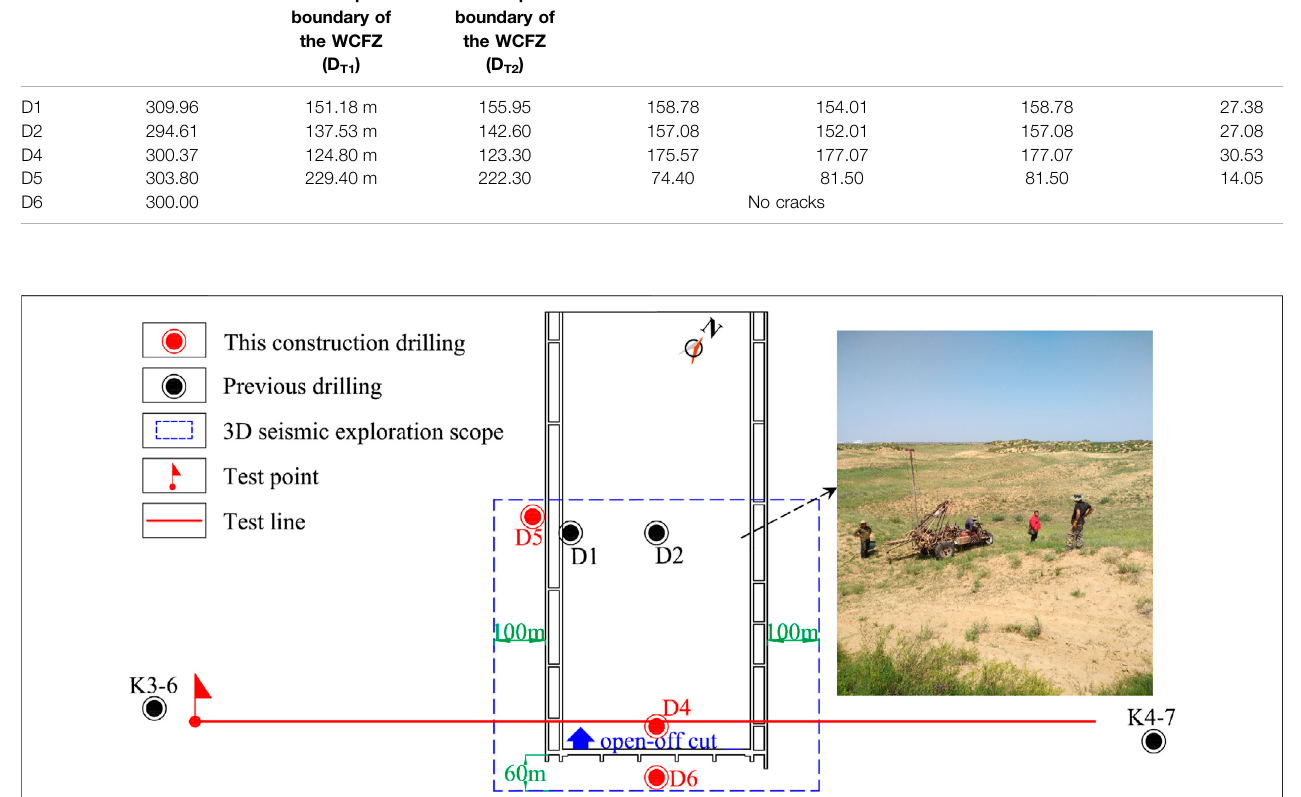
FIGURE 6 | 3D seismic exploration